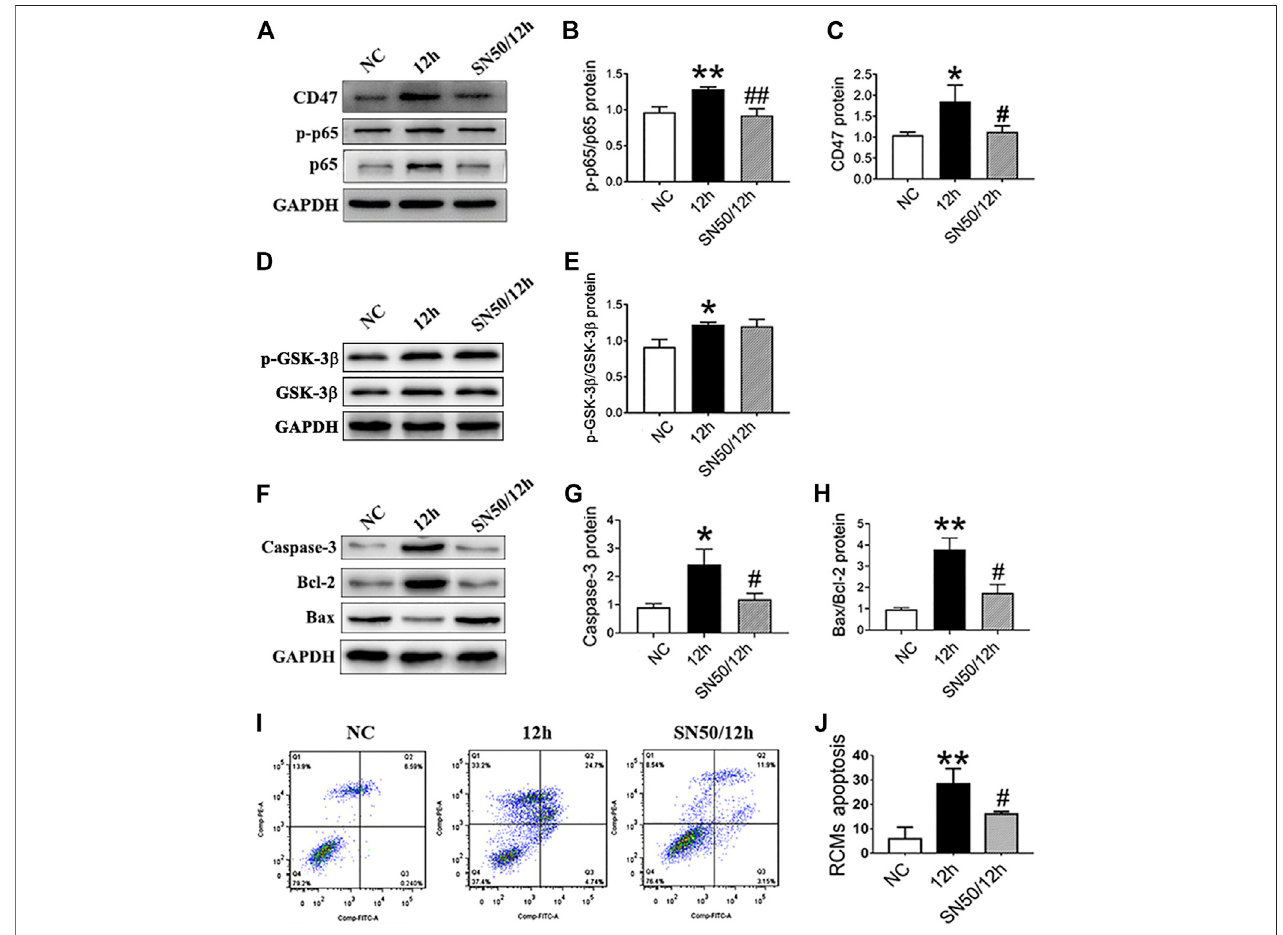
FIGURE 5 | NF- κ B inhibition decreases the CD47 expression and apoptosis rate in RCMs. (A – E) . Expressions of CD47, p-p65/p65 NF- κ B, and p-GSK-3 β /GSK- 3 β in RCMs under hypoxic conditions, as measured using western blot following SN50 pretreatment (18 μ M). (F – H) Western blot analysis of caspase-3, Bcl-2, and Bax expressions in hypoxic RCMs. (I, J) Flow cytometry detected a decrease in the apoptosis rate in hypoxic RCMs following SN50 pretreatment ( n (cid:2) 3/group). Data are presented as the mean ± SD. *p < 0.05, ** p < 0.01 vs. NC; # p < 0.05, ## p < 0.01 vs. 12